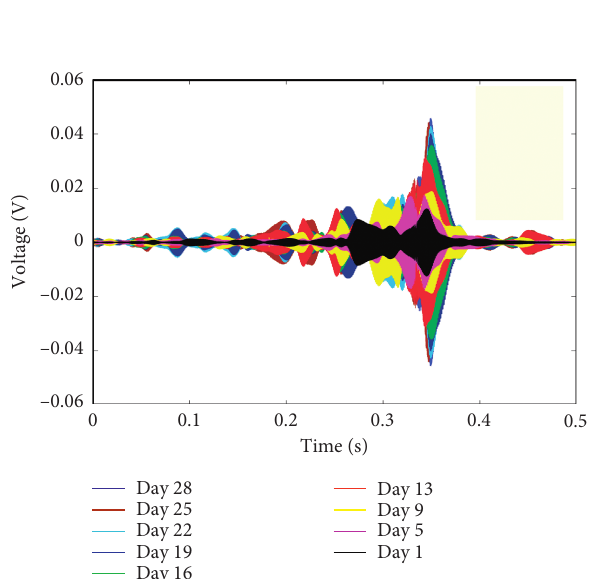
Figure 5: The received signal of the sensor.